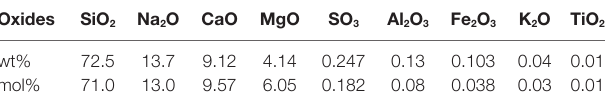
FiGUre 2 | Layout of the surface ablation Cell (sundberg et al., 2010) .